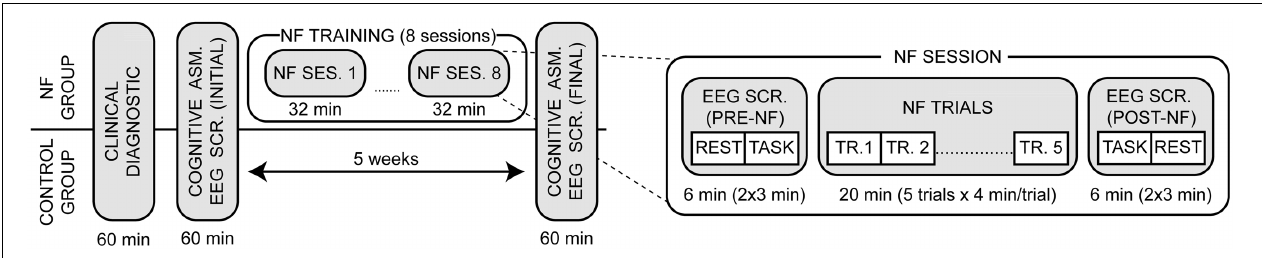
FIGURE 1 | Experimentaldesignofthestudy. Afteranintakediagnosticboth groups executed a pre- and post- cognitive assessment and EEG screening within a 5-week time interval. The NF group performed a total of eight NF